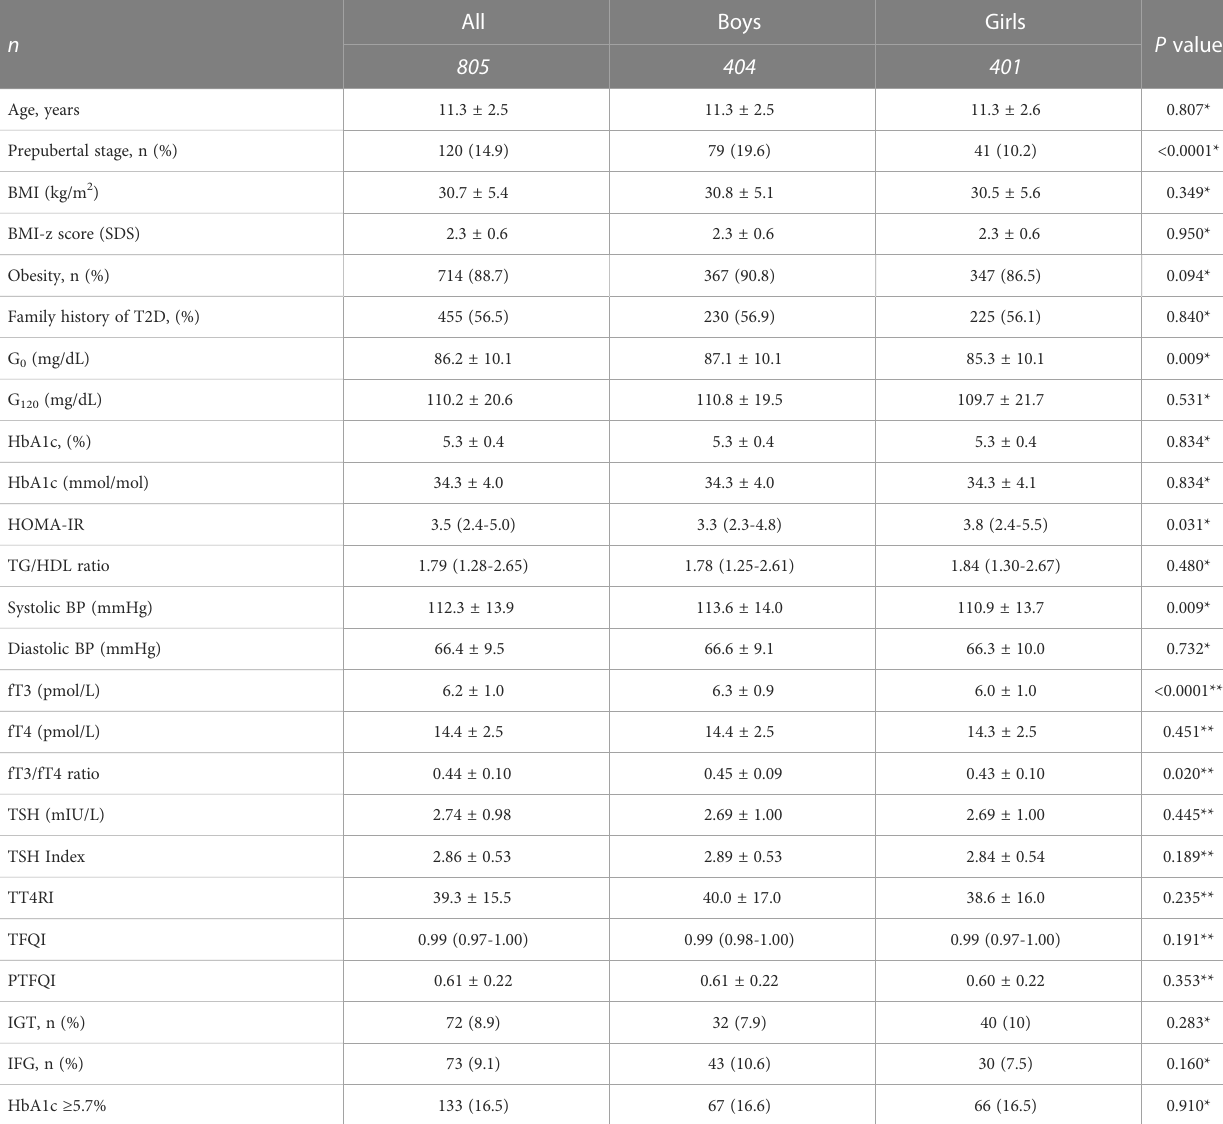
TABLE 1 Description of the sample as a whole and by